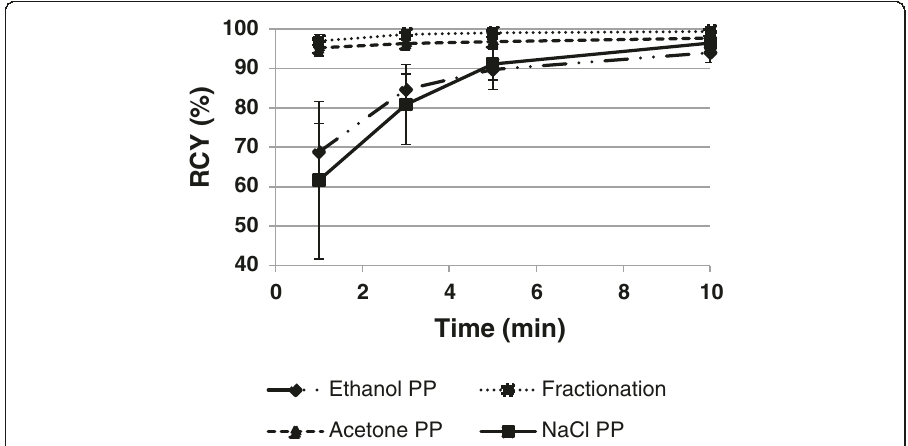
Fig. 4 Time dependent labelling for the formation of 68 Ga-DATATOC using 68 Ga post-processed by fractionation, acetone-, ethanol- and NaCl-based